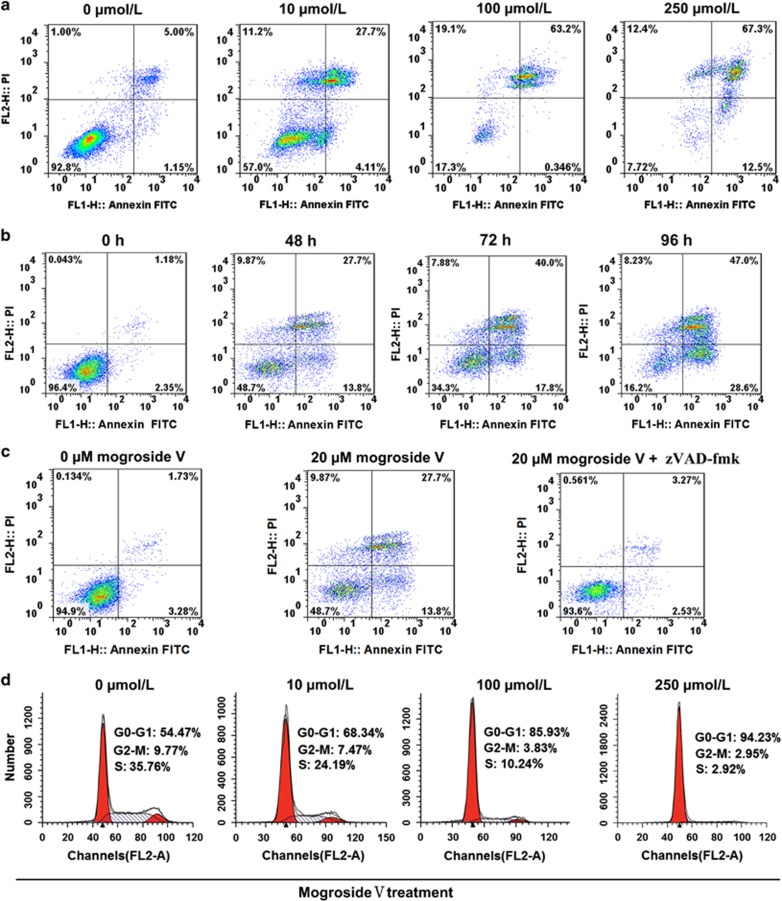
Apoptosis and cell cycle analysis of PANC-1 cells treated with mogroside V. (a) Representative flow cytometry plots from Annexin V assays indicating that mogroside V induced apoptosis in PANC-1 cells in a concentration-dependent manner and (b) a time-dependent manner. (c) PANC-1 cells were treated with or without mogroside V (20 μmol/l) for 48 h in the presence or absence of the apoptosis inhibitor zVAD (20 μmol/l). (d) Graphic indicating the cell cycle stages that were analyzed using flow cytometry. The percentage of cells in the G0/G1, S or G2/M phase of the cell cycle is indicated. An increase in the G0-G1 population was observed in the mogroside V-treated cells. The results were obtained in three independent experiments.